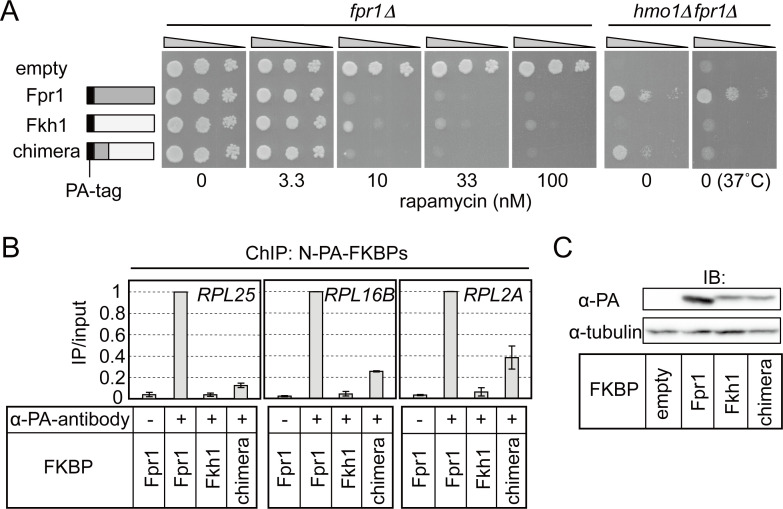
The Fpr1 N-terminal domain is critical for Fpr1 function as a transcriptional regulator.(A) Fpr1, Fkh1, and a mutant Fkh1 protein in which the N-terminal domain (aa 1–25) was replaced with its counterpart from Fpr1 (aa 1–31), were expressed in fpr1Δ cells. These proteins were N-terminally fused with PA-tag and expressed from the FPR1 promoter (Fpr1: pKM738, Fkh1: pKM774, and chimera: pKM795). The resulting strains were spotted onto SD plates containing or not containing rapamycin as indicated, and grown at 30°C for 3 days. The same proteins were also expressed in hmo1Δfpr1Δ cells, and the resulting strains were spotted onto SD plates lacking rapamycin and grown at 30°C or 37°C for 3 days. (B) Binding of FKBP proteins tested in (A) to specific Fpr1-target promoters (RPL25, RPL16B, and RPL2A) was examined by ChIP assays using anti-PA-tag antibody (as described in Fig 5D). (C) Expression of FKBP proteins used in (A) was examined through immunoblotting (as described in Fig 5E).